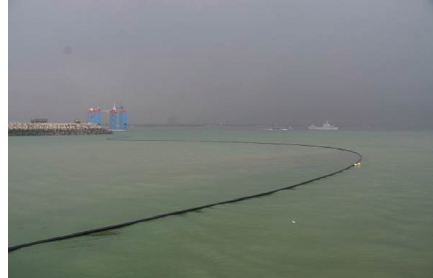
Figure 41: Floating pipeline department.